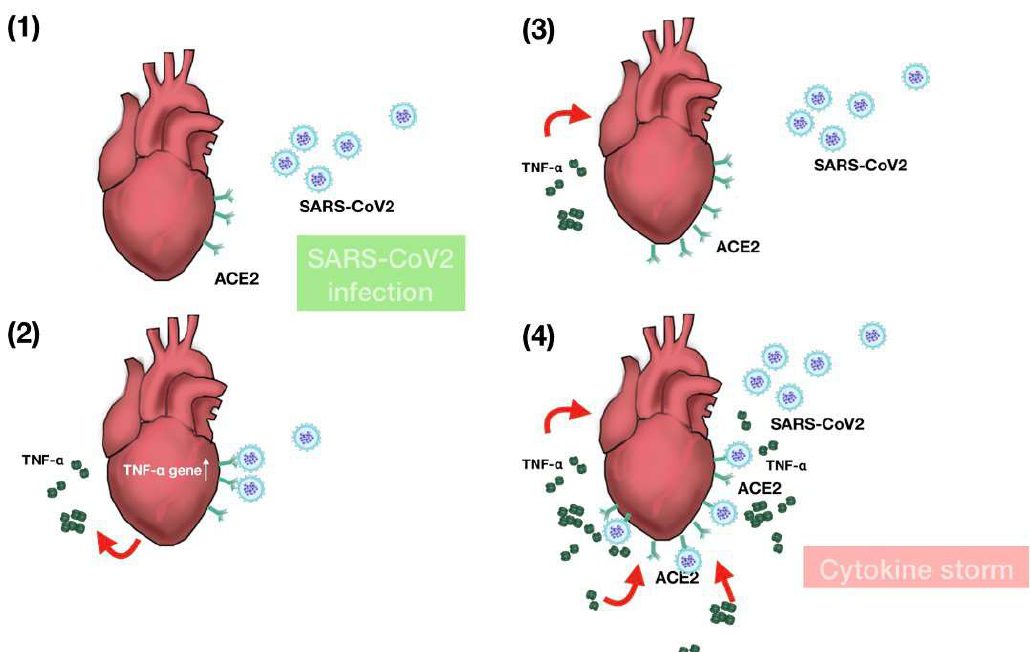
Figure 7. The enhanced SARS-CoV2 entry and TNF- α secretion may induce a cytokine storm in COVID19 patients. SARS-CoV2 binds to its ACE2 receptors in the heart ( 1 ) and increases the expression and secretion of TNF- α ( 2 ). The increased level of TNF- α upregulates ACE2 and TMPRSS2 expressions, resulting in the enhanced entry of SARS-CoV2 ( 3 ). The enhanced viral entry and TNF- α secretion may contribute to the cytokine storm ( 4 ).